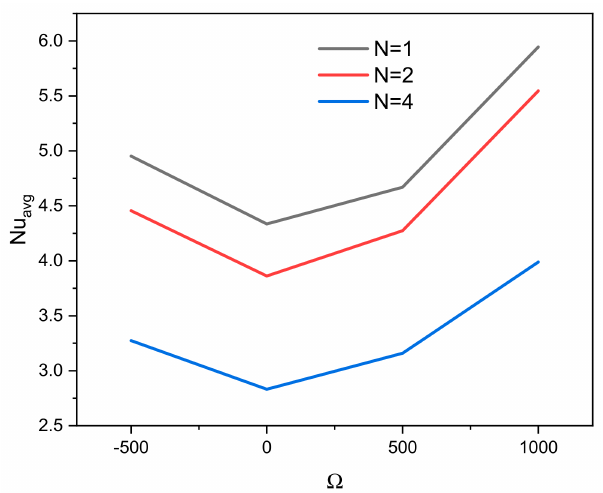
Figure 11. Effect of the values and direction of the cylinder rotation on the average Nusselt number for three zigzags number of the hot wall.